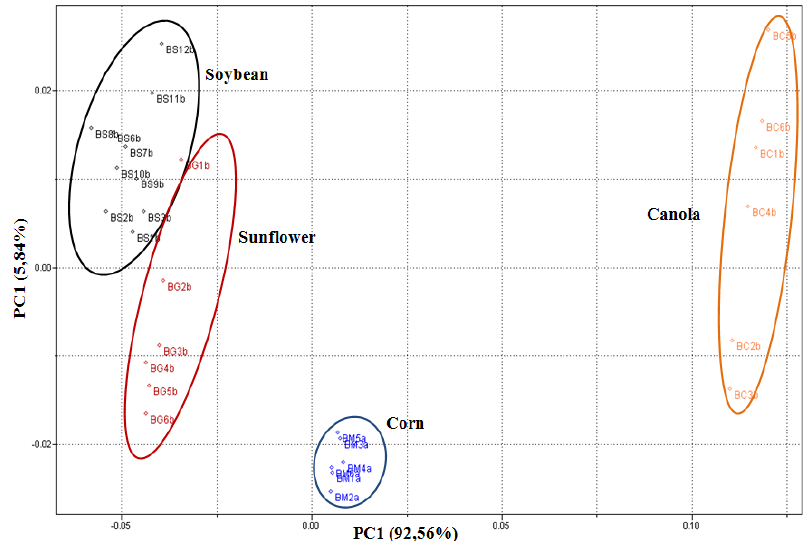
Figure 7. Scores plot (PC1 versus PC2) for the UATR-FTIR spectra of biodiesel samples used in the SIMCA training